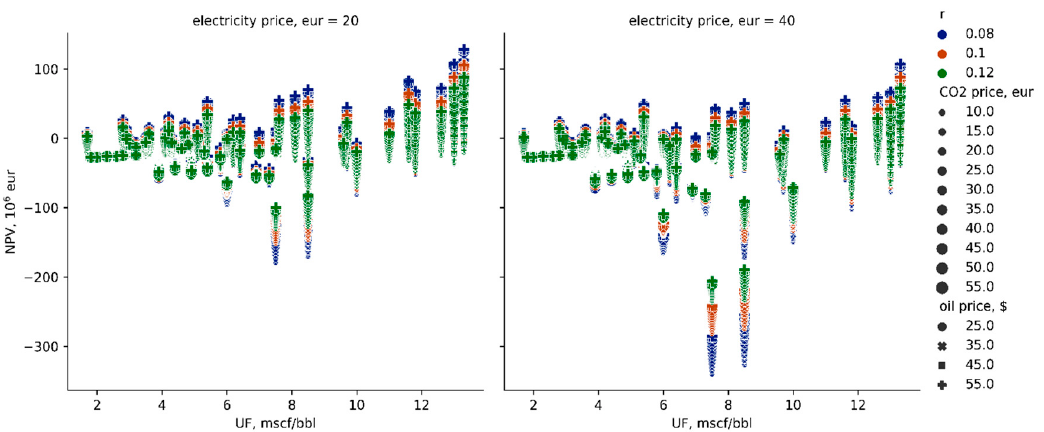
Figure 19. NPV vs. additional recovery after 15 years of CO 2 -EOR. The parameter which relates to additional recovery and retention was the utilization factor (Figure 20). If the only profit from additional oil recovery was observed, the lowest values of UF would be favorable because, in such cases, the highest recoveries could be achieved with the smallest amounts of CO 2 injected. NPV vs. UF showed a qualitatively similar trend to that in NPV vs. retention.